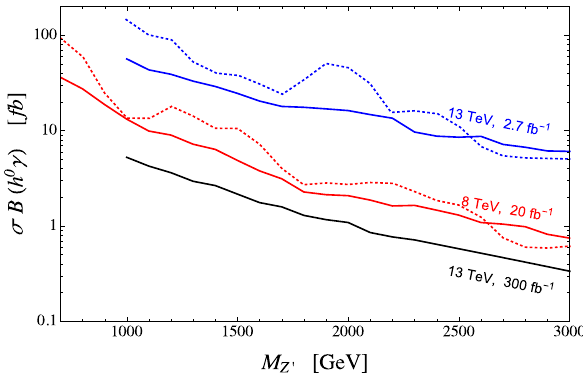
Fig. 1 Estimated limits on the cross section for an h 0 γ resonance obtained by recasting the pp → q ∗ → γ q search results: current √ s = 13 TeV and 8 TeV (solid blue and red lines, respec- limits at tively), and projected limit at 13 TeV with L = 300 fb − 1 (solid black line). For comparison, dotted lines represent the current CMS [15,16] limits on the cross section times branching fraction for an excited quark decaying q ∗ → γ q ; the improvement by a factor of approximately 1.5 over much of the mass range is the result of applying the Higgs tagger